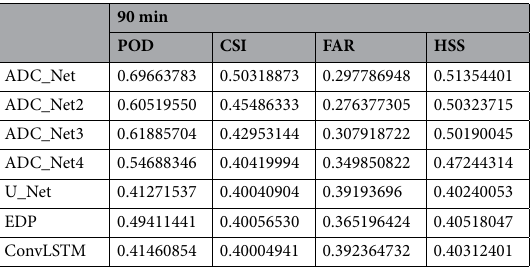
Table 3. 90-min radar echo extrapolation evaluation scores.